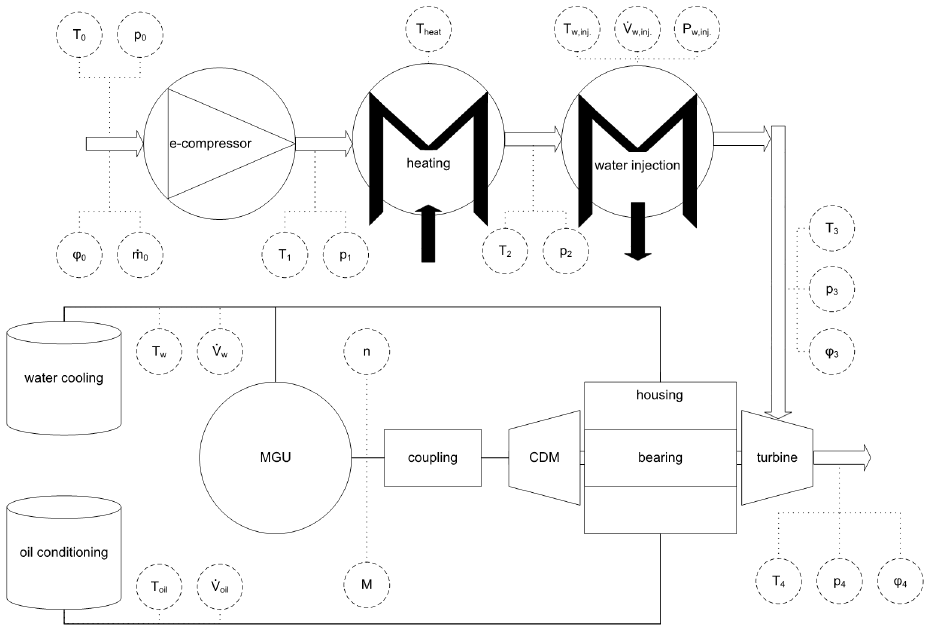
Figure 7. HGTB–schematics of test bed setup with water injection